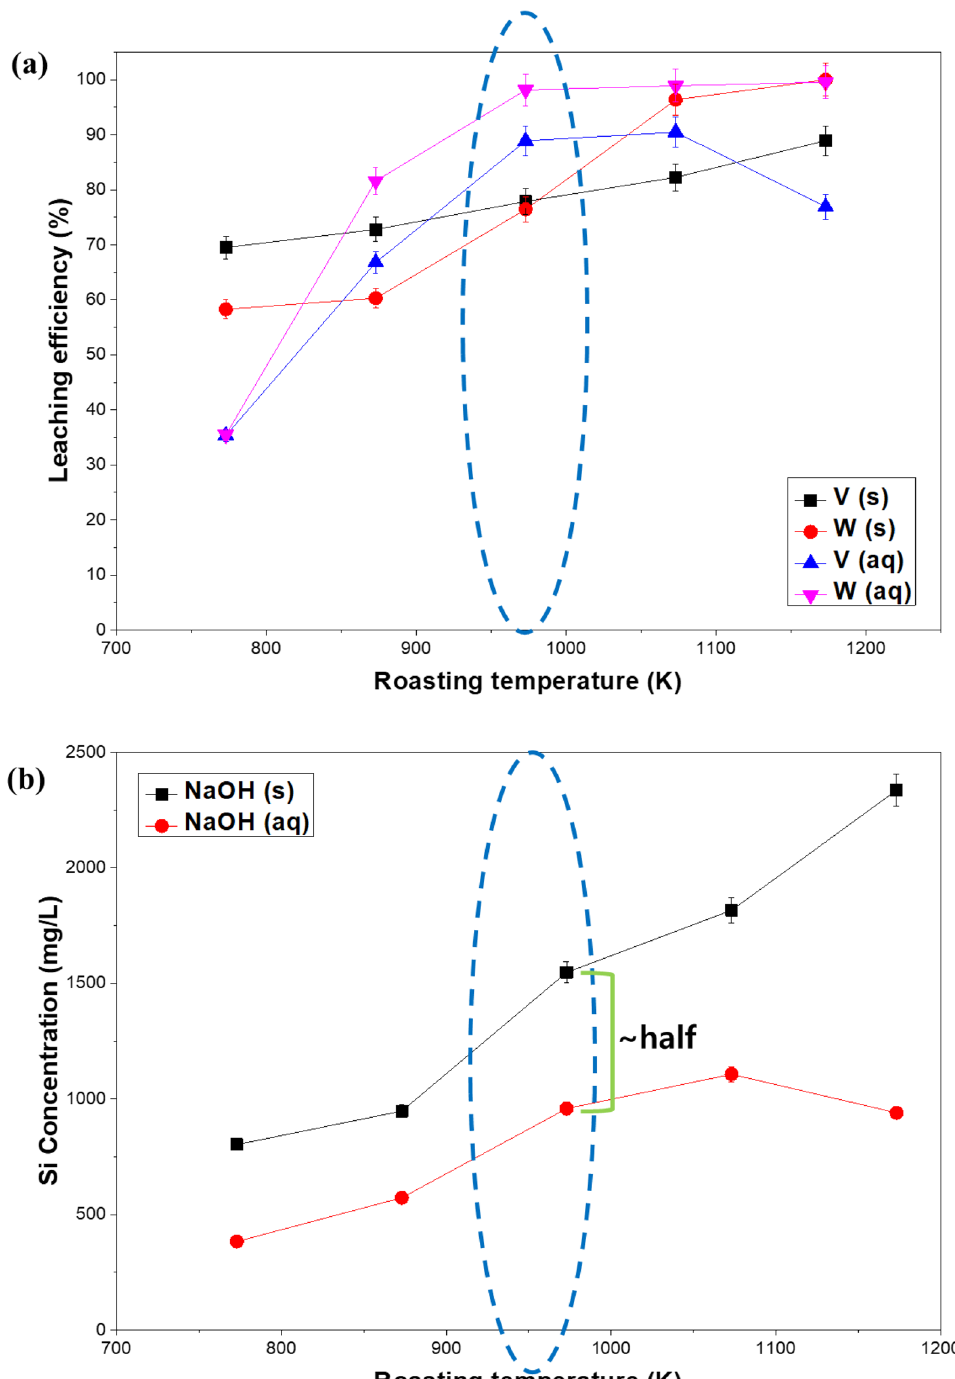
Figure 1. Effects of temperature at the time of roasting process (s = solid, aq = aqueous) in the ( a ) leaching of vanadium and tungsten and ( b ) in the concentration of Si